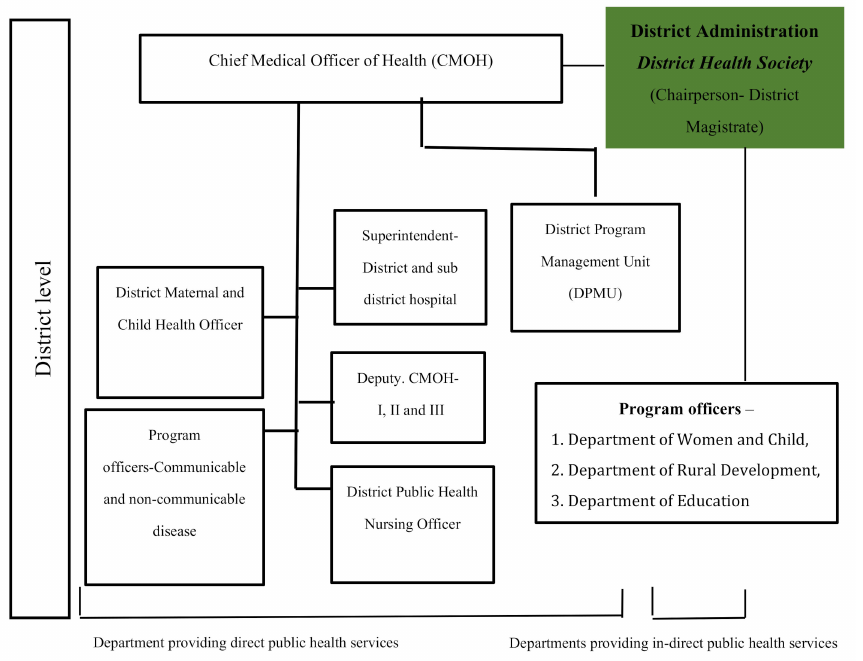
Figure 1. Health system connectivity at the district level in West